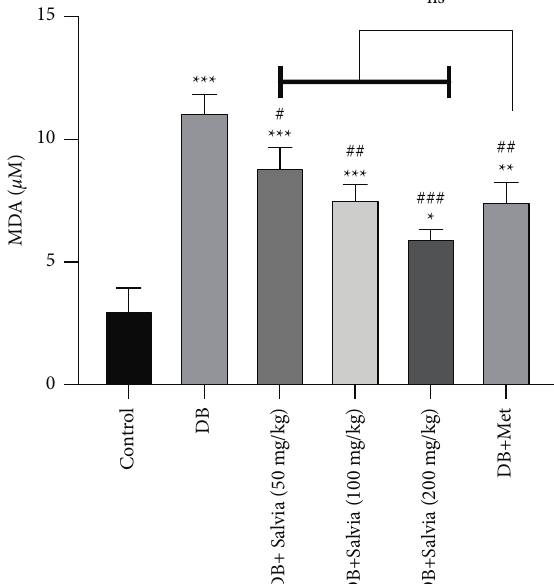
Figure 10: Effect of Salvia spinosa extracts on mitochondrial lipid peroxidation in renal isolated mitochondria in streptozotocin-induced diabetic mice. Control: normal mice, DB: diabetic mice, DB +Salvia: diabetic mice given the methanolic extract of Salvia spinosa , and DB+ Met: diabetic mice given metformin (500mg/kg). Values represented as mean ± SD. ∗ P < 0 . 05 compared with control mice. ∗∗ P < 0 . 001 compared with control mice. ∗∗∗ P < 0 . 001 compared with control mice. # P < 0 . 05 compared with diabetic mice. ## P < 0 . 01 compared with diabetic mice. ### P < 0 . 001 compared with diabetic mice. Ns: